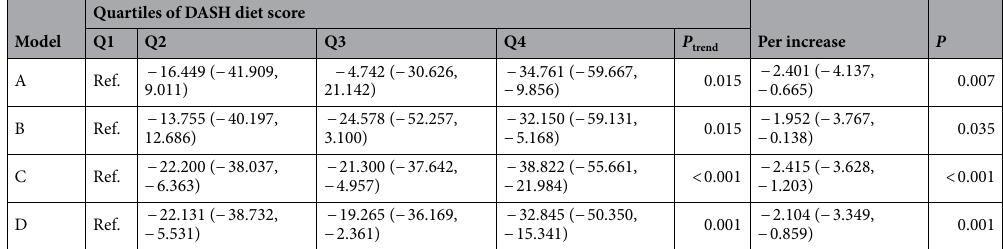
Table 4. Sensitivity analysis of the association between DASH diet score and SUA levels. Model A: Excluding participants with history of diabetes, history of hypertension, history of hyperuricemia and gout, adjusted for gender, age, BMI, married status, occupation, education level, smoking, alcohol drinking, family history of gout and uric-acid-lowering drug intake. Model B: Excluding participants with history of diabetes, history of hypertension, history of hyperuricemia, history of gout, family history of gout, adjusted for gender, age, BMI, married status, occupation, education level, smoking, alcohol drinking, and uric-acid-lowering drug intake. Model C: Excluding participants with the extreme values of SUA, adjusted for gender, age, BMI, married status, occupation, education level, smoking, alcohol drinking, history of diabetes, history of hypertension, history of hyperuricemia, history of gout, family history of gout and uric-acid-lowering drug intake. Model D: Excluding participants with uric-acid-lowering drug intake, adjusted for gender, age, BMI, married status, occupation, education level, smoking, alcohol drinking, history of diabetes, history of hypertension, history of hyperuricemia, history of gout, family history of